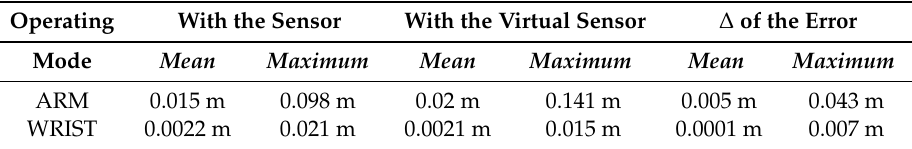
Table 1. Mean and maximum motion errors of the position controller.